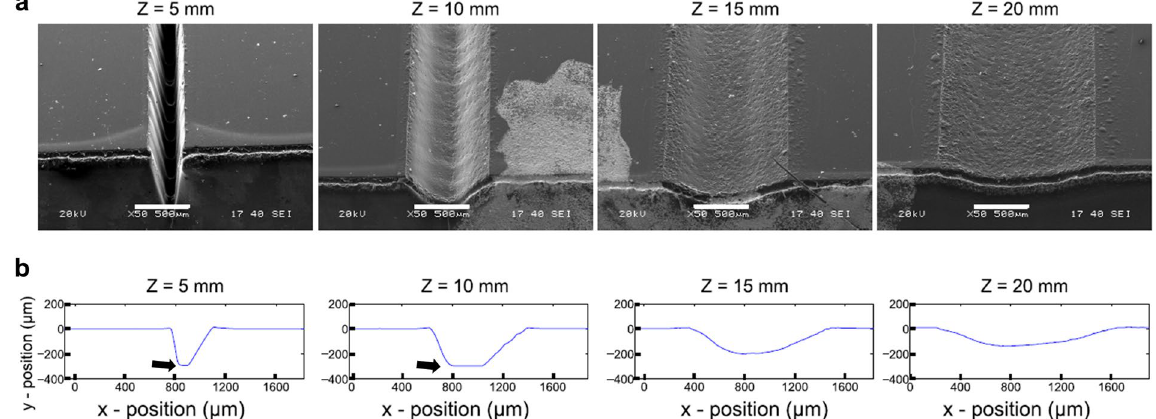
Figure 2. Effect of distance-to-focus on channel geometry. Cross-section and morphology of microfluidic channels laser-engraved (30% power, 10% speed) at varying distance-to-focus (Z = 5, 10, 15 and 20 mm respectively). ( a ) Scanning electron microscopy of the engraved channels (tilt 45°) reveals high aspect ratio (deep and narrow) channels at low distances, and low aspect ratio (shallow and wide) channels at higher distances. Scale bar: 500 μ m. ( b ) Profilometer analysis of the microfluidic channels reveals changes in cross- section (from a narrow gaussian morphology to semicircular) with increasing level of laser unfocusing. Axes show real aspect ratio. For the 5 mm and 10 mm FD channels, the stylus profilometer reaches the limit of its measurement range, resulting in a flat profile curve (black arrows).